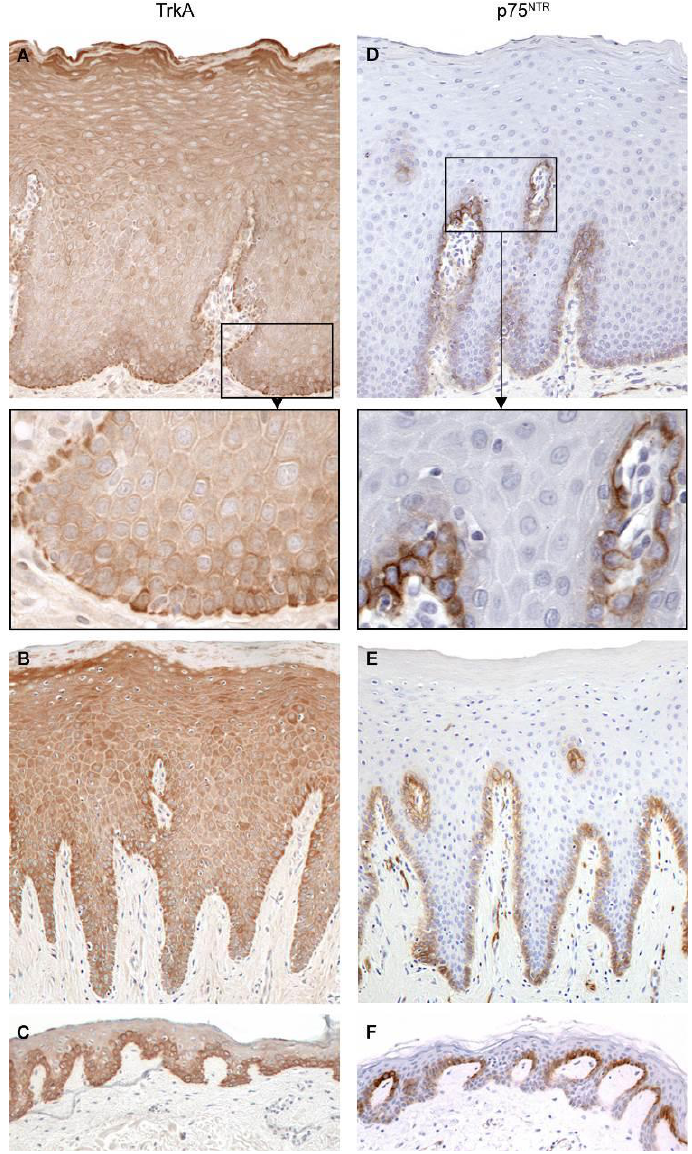
Figure 5. Immunohistological staining for pro-nerve growth factor NGF receptor tropomyosin-related kinase A (TrkA) ( A – C ) and NGF receptor p75 neurotrophin receptor (p75 NTR ) ( D – F ) in the normal epithelium from normal oral mucosa (NOM; A , D ), gingiva ( B , E ), and skin ( C , F ). Original magnification, 20 ×. With permission from ref. [14].